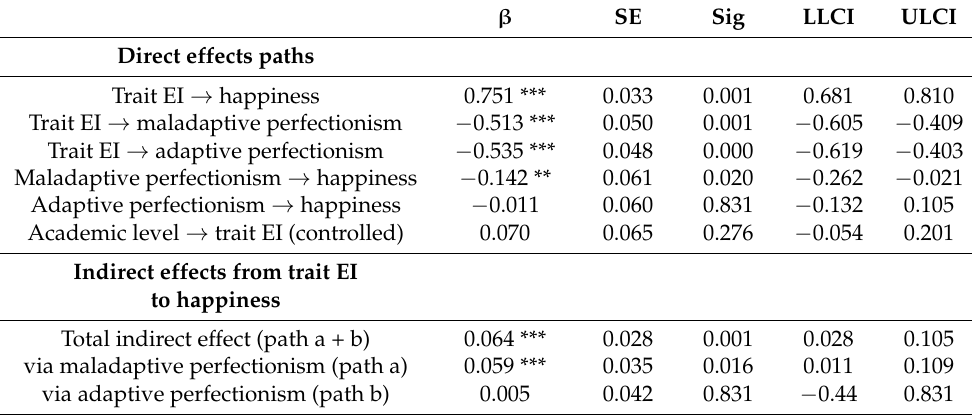
Table 2. Regression results and mediating effects of